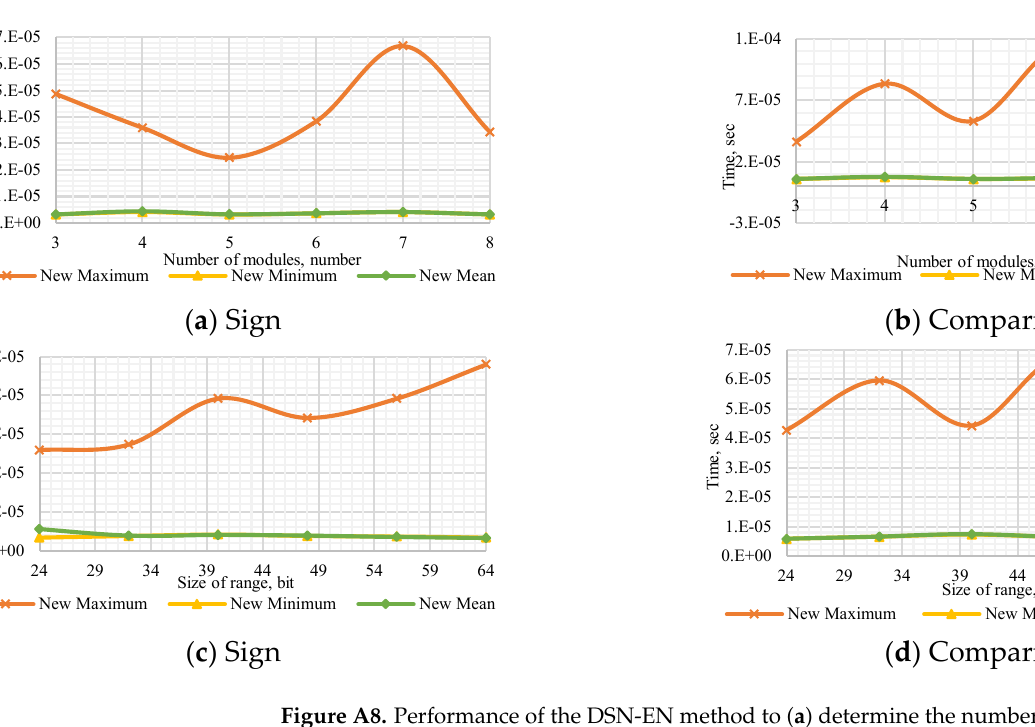
Figure A7. Performance of the Sign of Number Method to ( a ) determine the number’s sign with a dynamic number of modules p , ( b ) compare dynamic numbers of modules p , ( c ) determine the number’s sign with a dynamic bit width, and ( d ) compare numbers with dynamic bit width.